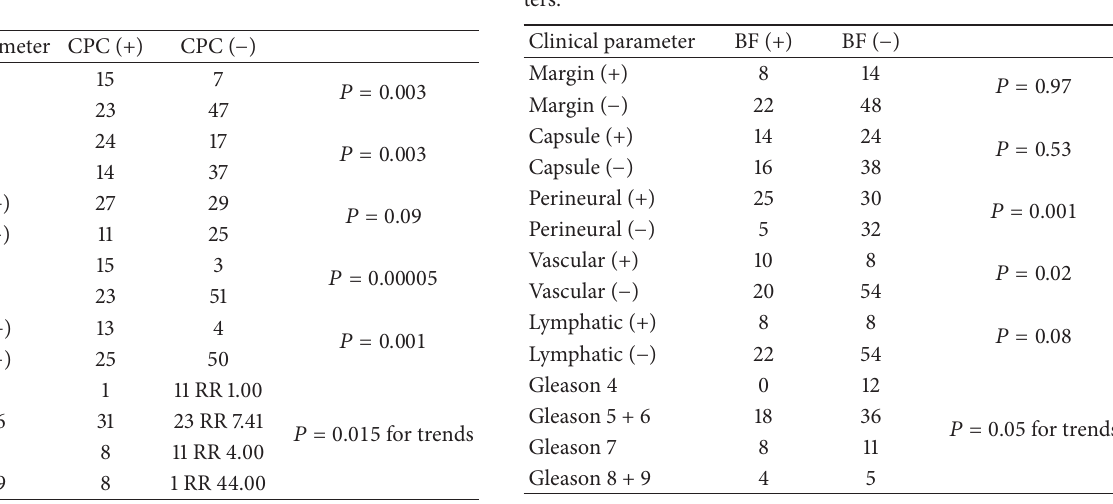
Table 2: Secondary CPC detection and association with clinical parameters.